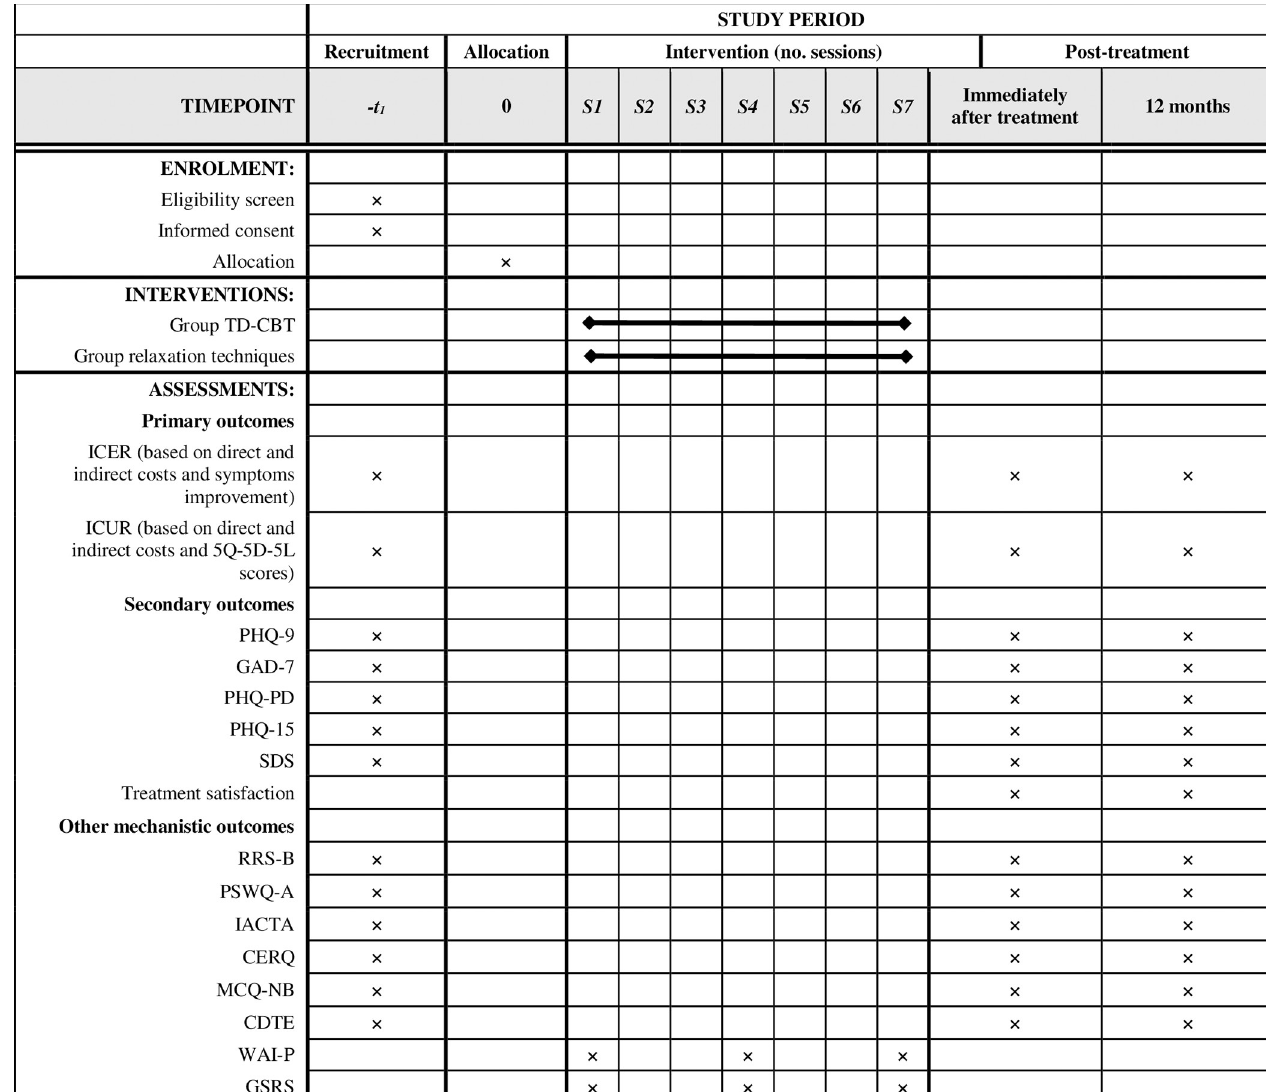
Fig 3. Study timeline according to SPIRIT statement. CDTE: Questionnaire of Cognitive Distortions in Emotional Disorders; CERQ: Cognitive Emotion Regulation Questionnaire; EQ-5D-5L: 5-dimension, 5-level European Quality of Life scale; GAD: Generalized Anxiety Disorder; IACTA-PB: Inventory of Cognitive Activity in Anxiety Disorders-Panic Brief subscale; ICER: incremental cost-effectiveness ratio; ICUR, incremental cost-utility ratio; MCQ-NB: Metacognitions Questionnaire-Negative Beliefs subscale; PHQ: Patient Health Questionnaire; PSWQ-A: Penn State Worry Questionnaire-Abbreviated; RRS-B: Ruminative Responses Scale-Brooding subscale; SDS: Sheehan Disability Scale; TAU: treatment as usual; TD-CBT: transdiagnostic cognitive-behavioural therapy; WAI-P: Working Alliance Inventory Patient Form; GSRS: Group Session Rating Scale.